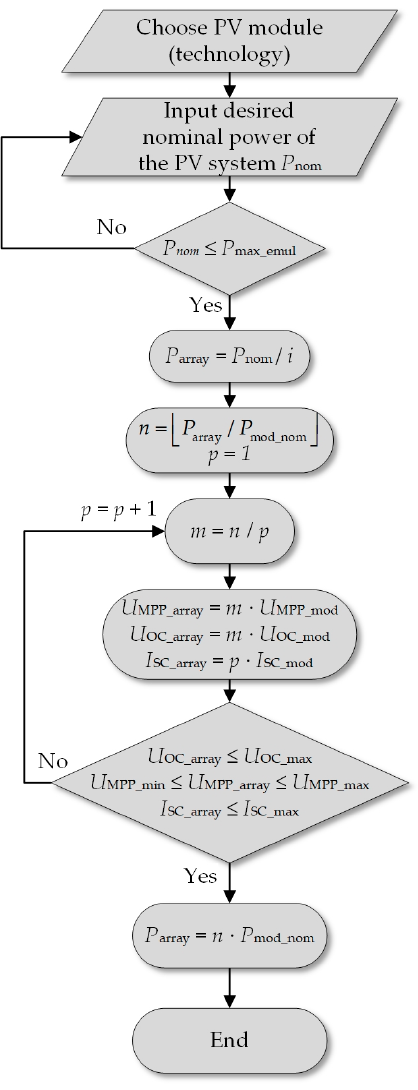
Figure 4. Flowchart of the algorithm for determining PV plant configuration. Energies 2020 , 13 , x FOR PEER REVIEW